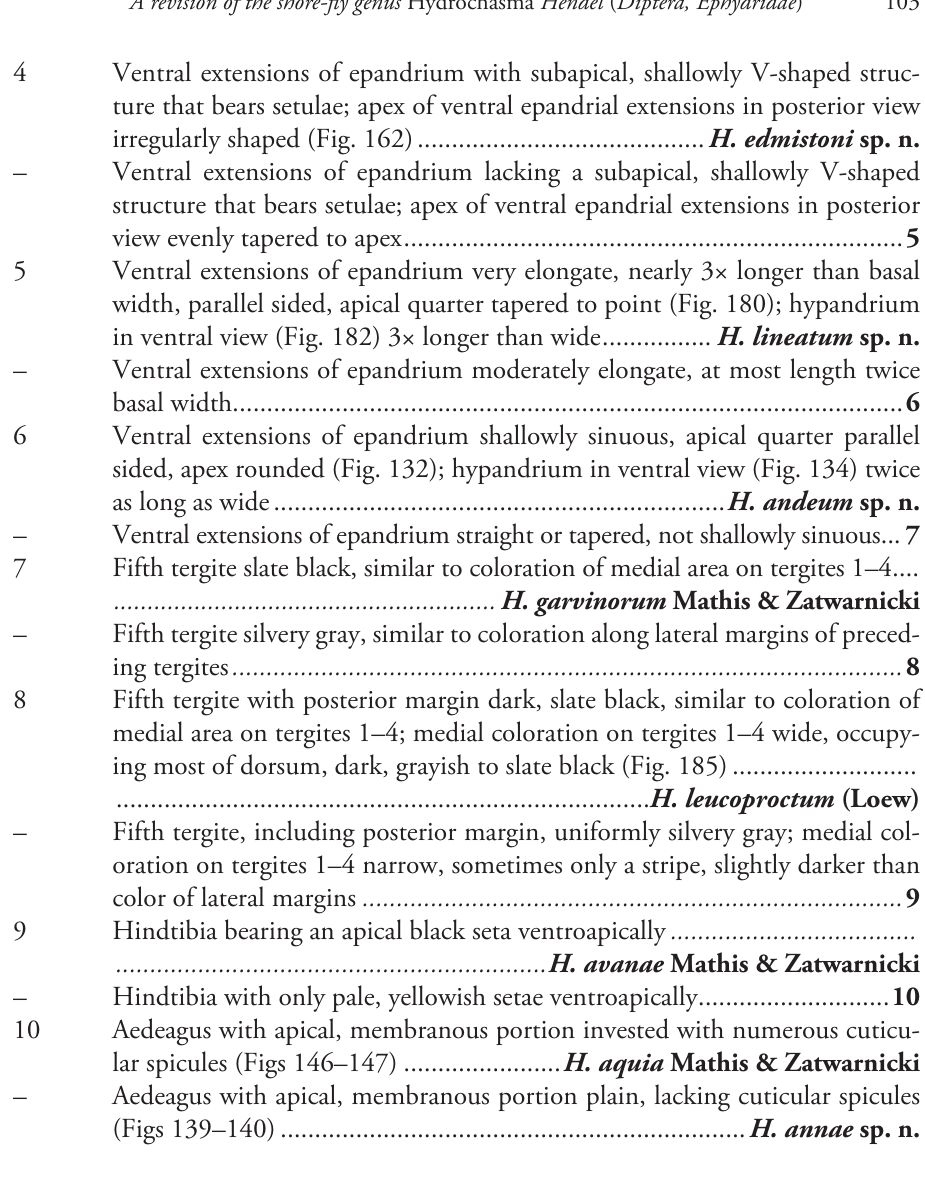
Ventral extensions of epandrium with subapical, shallowly V-shaped struc- ture that bears setulae; apex of ventral epandrial extensions in posterior view